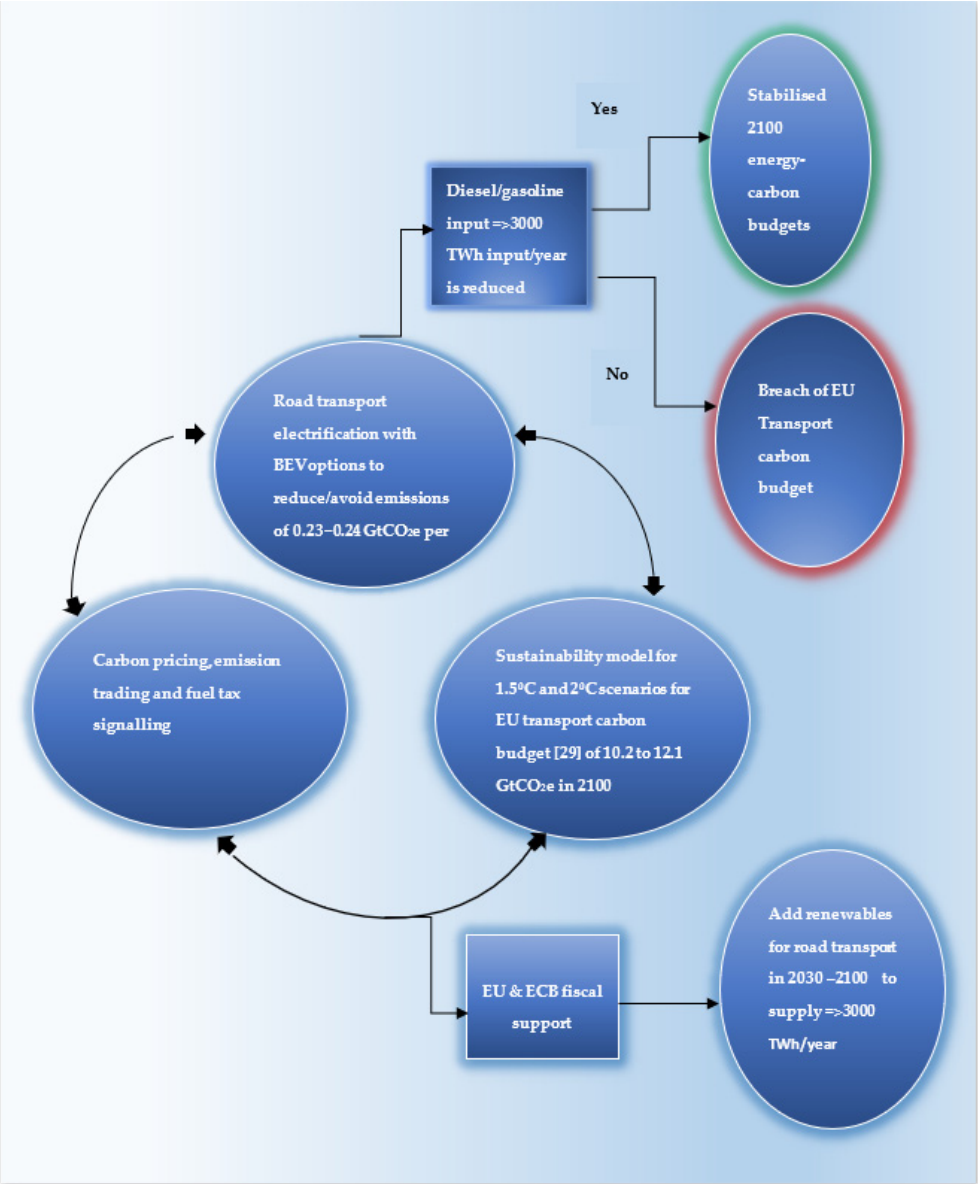
Figure 3. Future policy paths.